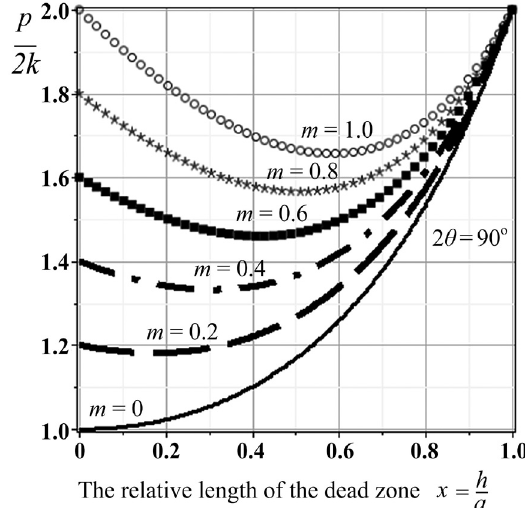
Figure 3. Relative ECAE pressure p /2 k, calculated by Formula 3 at different values of friction factor